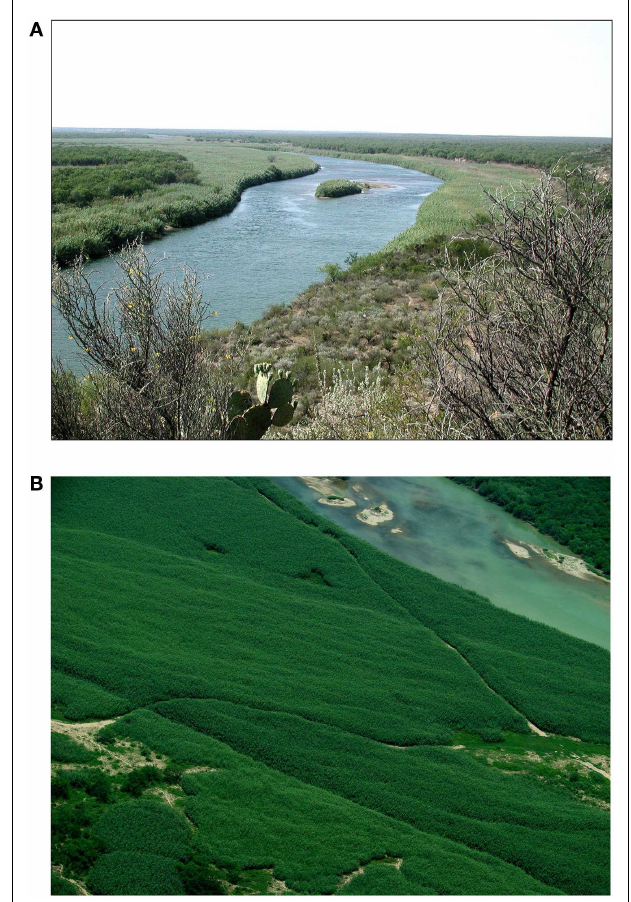
FIGURE 1 | Invasion of exotic Arundo donax , giant reed, is facilitating the invasion of Cattle FeverTicks in the transboundary region by creating a microclimate that is favorable for its survival . (A) Arundo donax on Rio Grande near Eagle Pass,TX, USA. (B) Arundo donax on Rio Grande near Del Rio,TX,